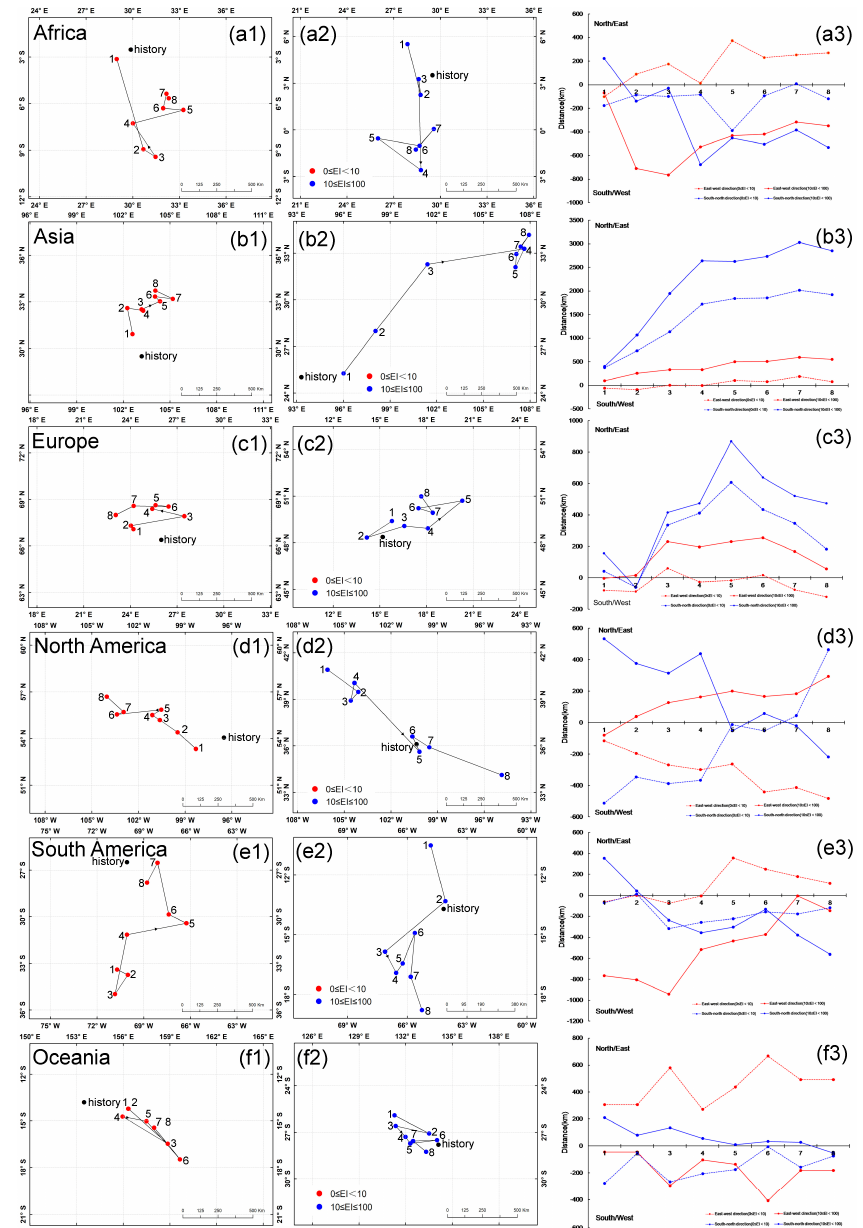
Figure 7. Shift paths and relative shift distances in central points for climate-unsuitable (0 ≤ EI < 10, red points) and climate-suitable (10 ≤ EI < 100, blue points) regions in future decades (2021–2100) in different continents (except Antarctica). Black points in Figure 7a1–f1 and a2–f2 represent the central points of historical distributions, and the numbers in Figure 7a1–f1 and a2–f2 represent di ff erent periods from 2021 to 2100. Figure 7a3–f3 reflects the relative shift distance of central points in two directions (north–south and east–west) in future decades compared with historical central points (1987–2016). Positive values denote points lying in the north / east of historical positions, and negative values denote the south / west direction. Positive and negative slopes reflect the shift directions of central points, representing northward / eastward and southward / westward,